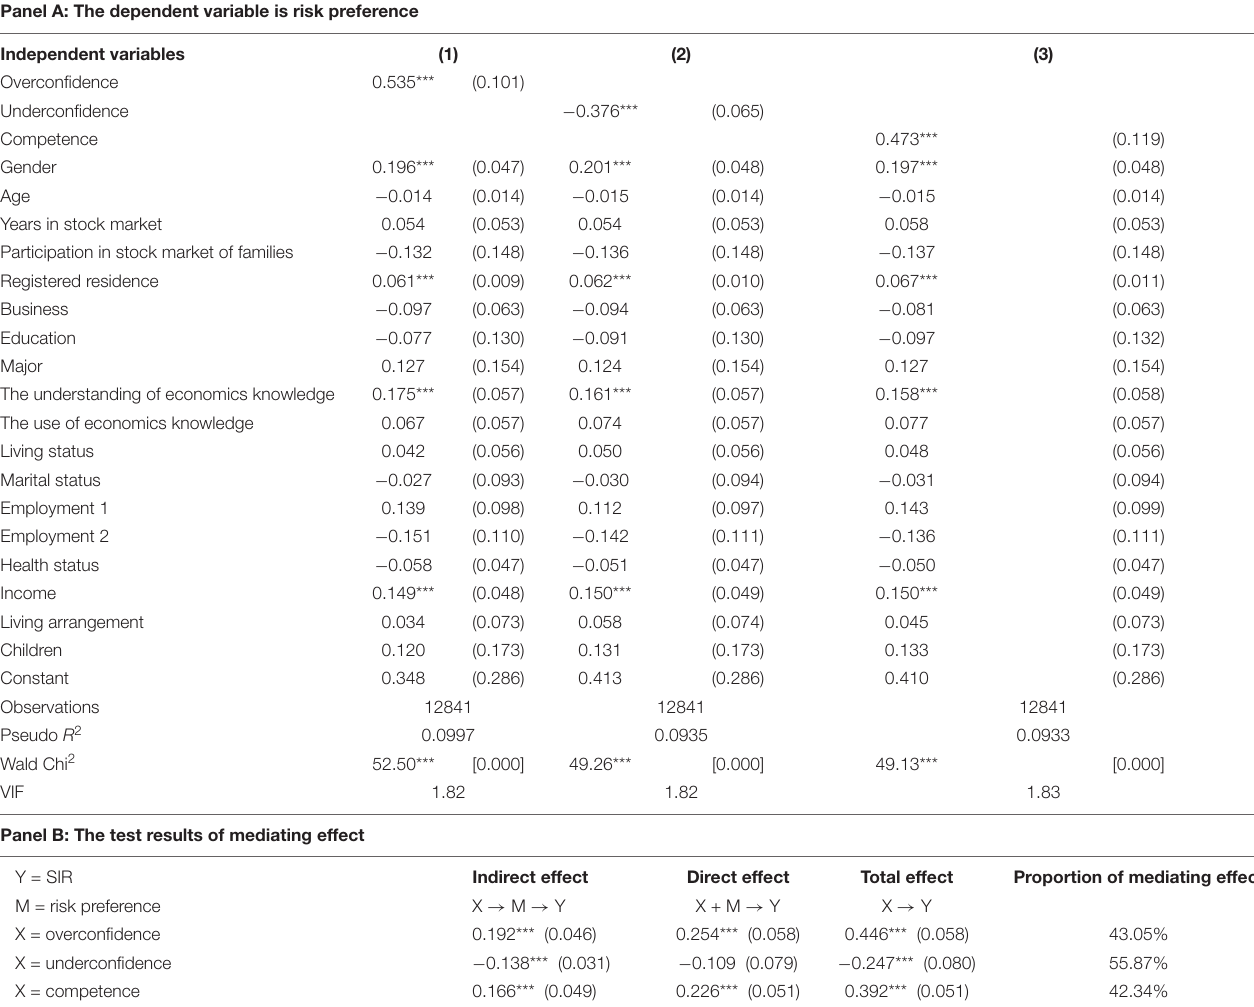
TABLE 10 | The mediating effect of risk preference in the relationship between composite FL and SIR. Panel A: The dependent variable is risk